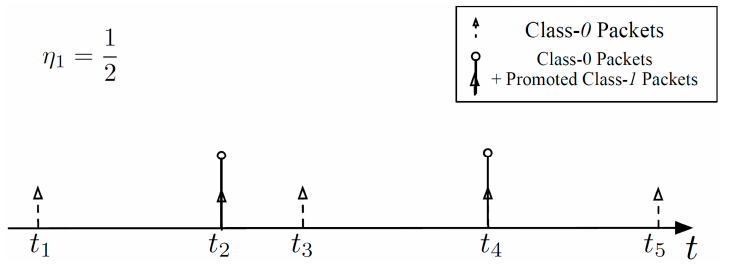
Figure 6. An example of packets arriving at Buffer-0 with η 1 = 1/2.